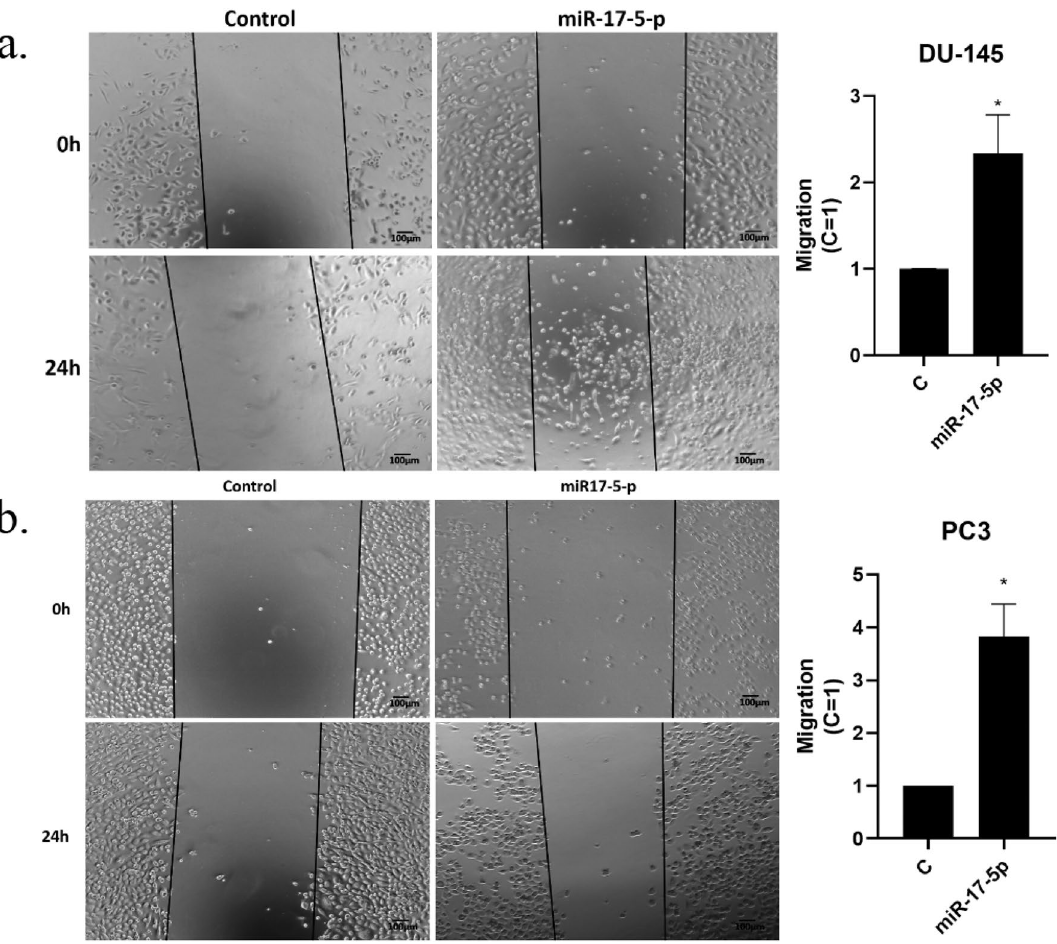
Figure 5. Migration in PC3 and DU145 cell lines were measured using wound healing assays. miR-17-5p transfected cells were compared with controls. Both PC3 and DU145 cell lines showed significant migration ( p < 0.05) compared to controls. Figure are representative results from three experiments for PC3 and DU145. Full results from the experiments are presented in Supplementary Table S3 (PC3 and DU145). ( a ) Wound healing assays for DU145; ( b ) Wound healing assays for